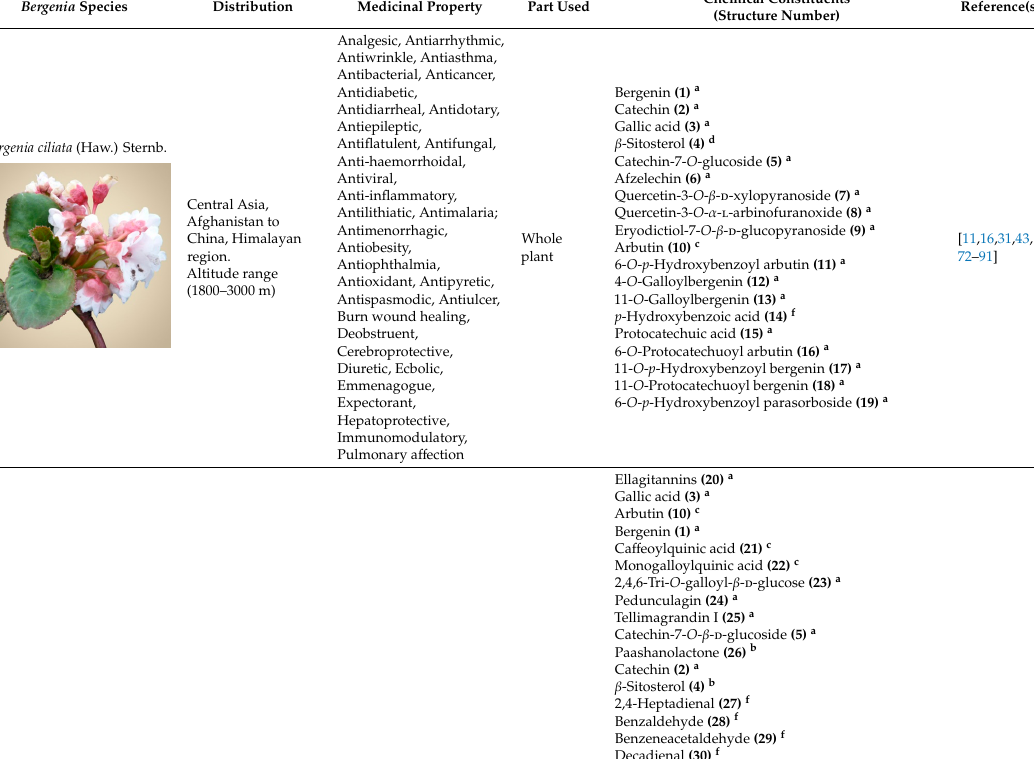
Bergenia ciliata (Haw.) Bergeniaciliata (Haw.) Sternb.